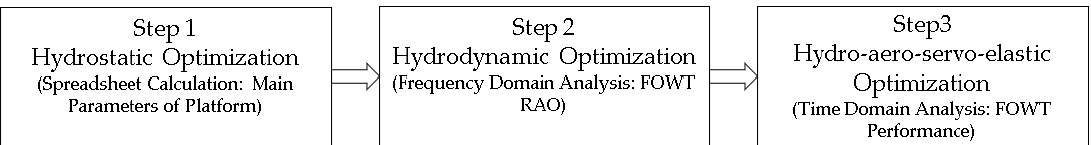
= response amplitude